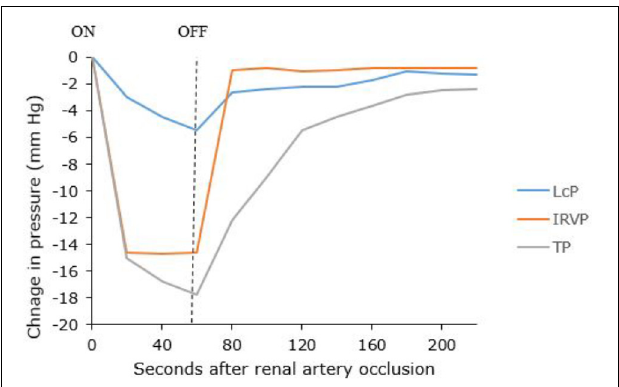
FIGURE 5 | Changes in capsular lymph pressure (LcP), intra-renal venous pressure (IRVP), and tissue pressure (TP) before, during and after a 60-s renal artery occlusion. Adapted with permission from Bell et al.